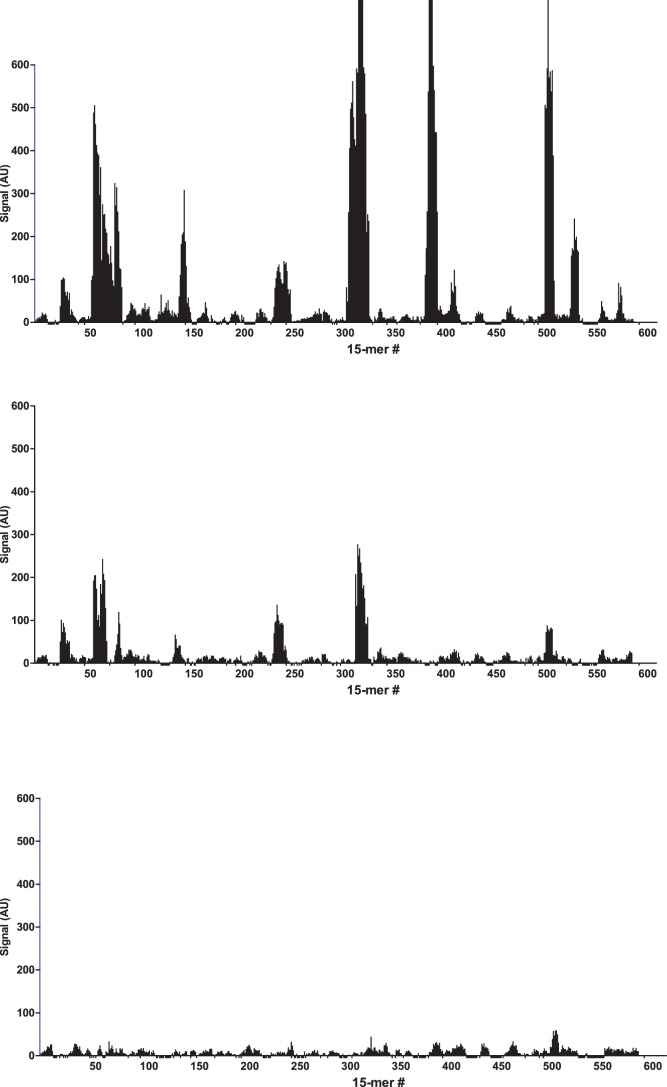
Signals.Bar chart displaying the fluorescence signal obtained from binding of polyclonal anti-HSA to 15-mer peptides with 14 residue overlap (average signal from 5 copies of each peptide). A: peptides from HSA, B: peptides from BSA and C: peptides from RSA. The peptides are numbered on the x-axis according to the position of their n-terminal residue in the protein sequence. The y-axis denotes the average intensity of the signal (AU) after background subtraction.